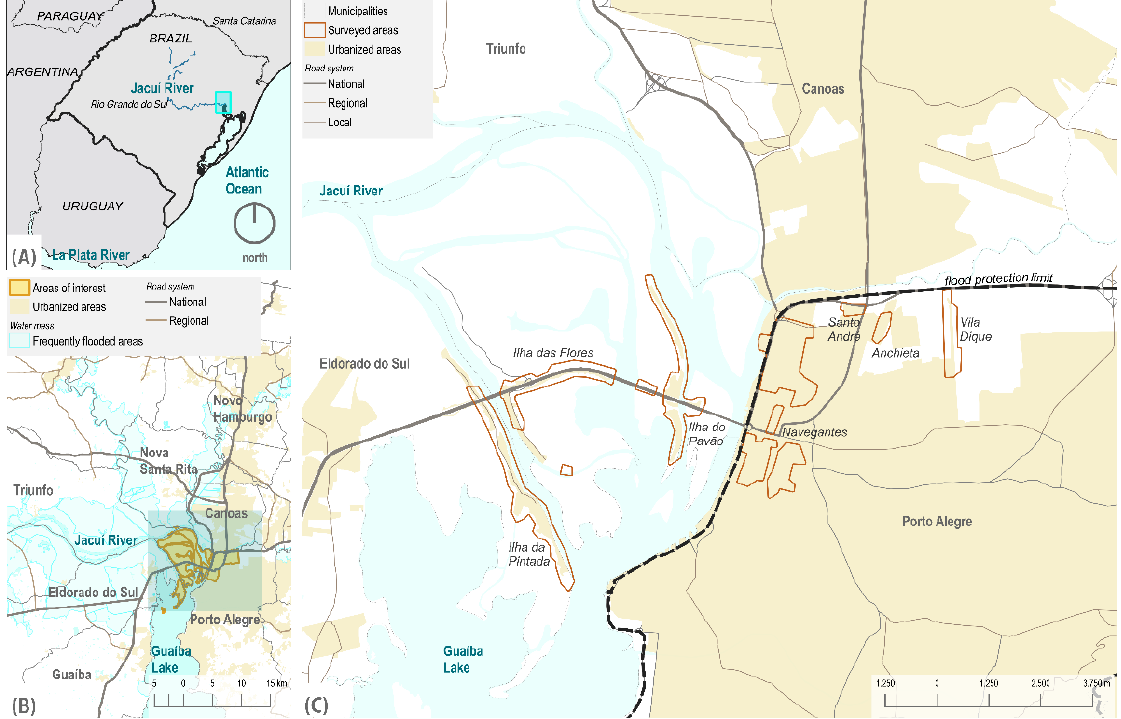
Figure 1. Location of surveyed areas: ( A ) location in the south of Brazil; ( B ) surveyed areas in the Jacuí delta; and ( C ) location of surveyed areas and the flood protection limit.